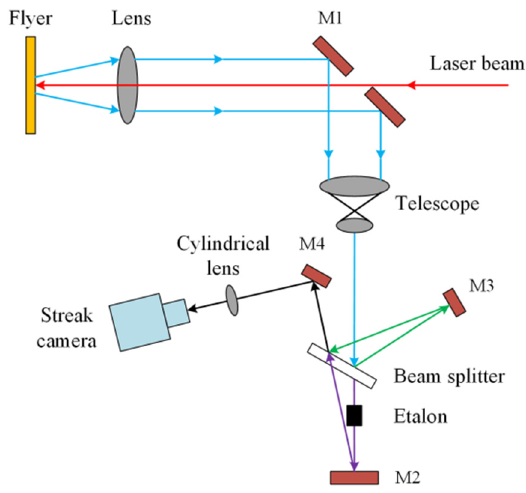
Figure 11. Interferometer configuration for ORVIS.